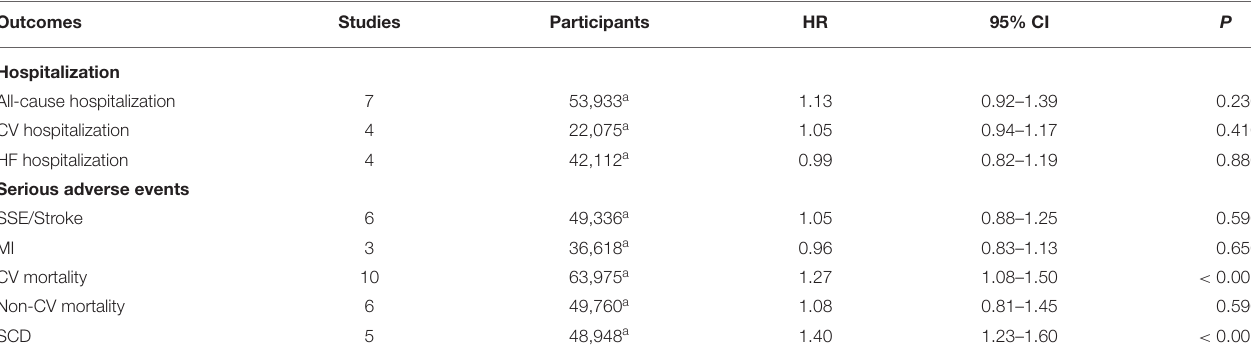
TABLE 3 | Additional analyses of the association between digoxin treatment and other clinical outcomes.